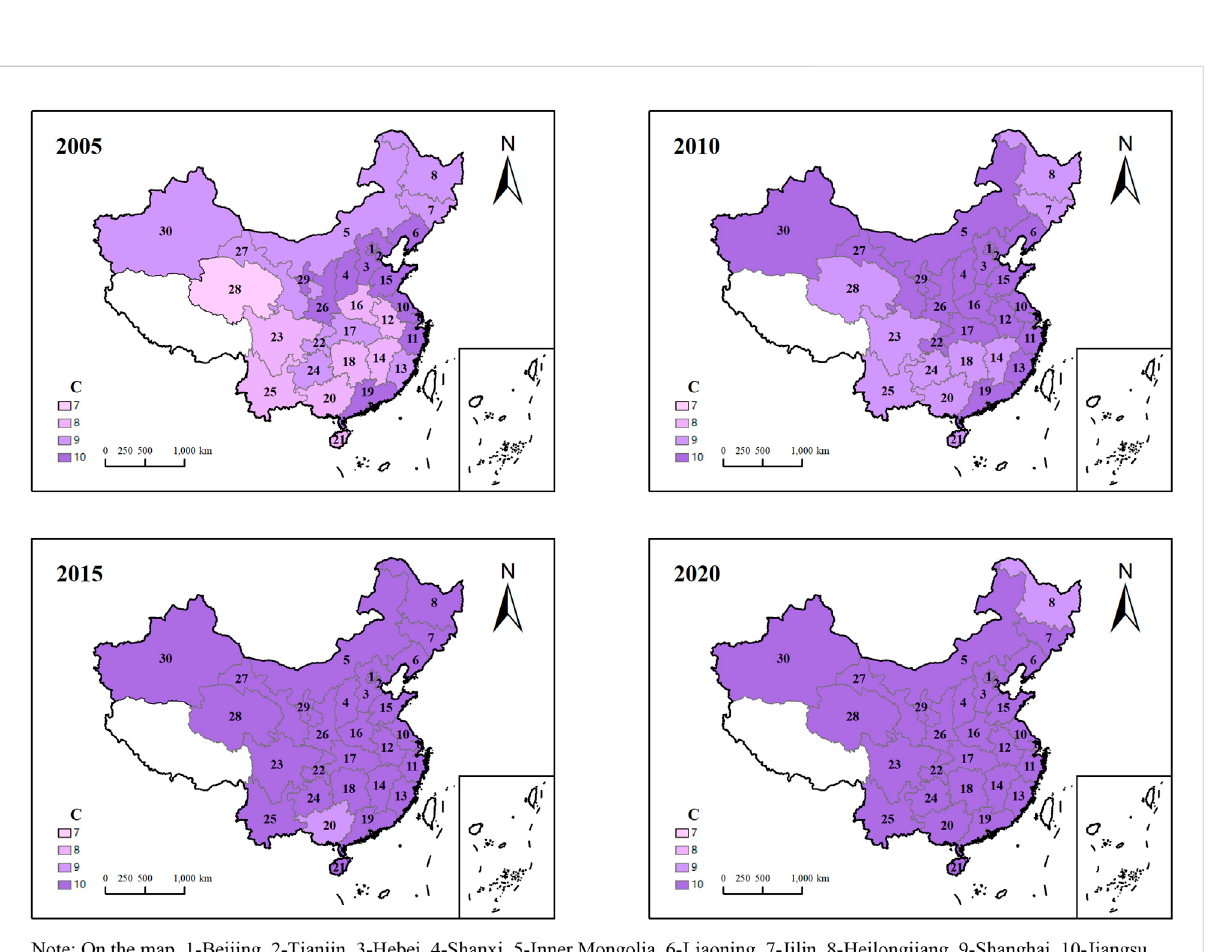
FIGURE 5 Spatial evolution of coupling level between HQD and RECC of 30 provinces.